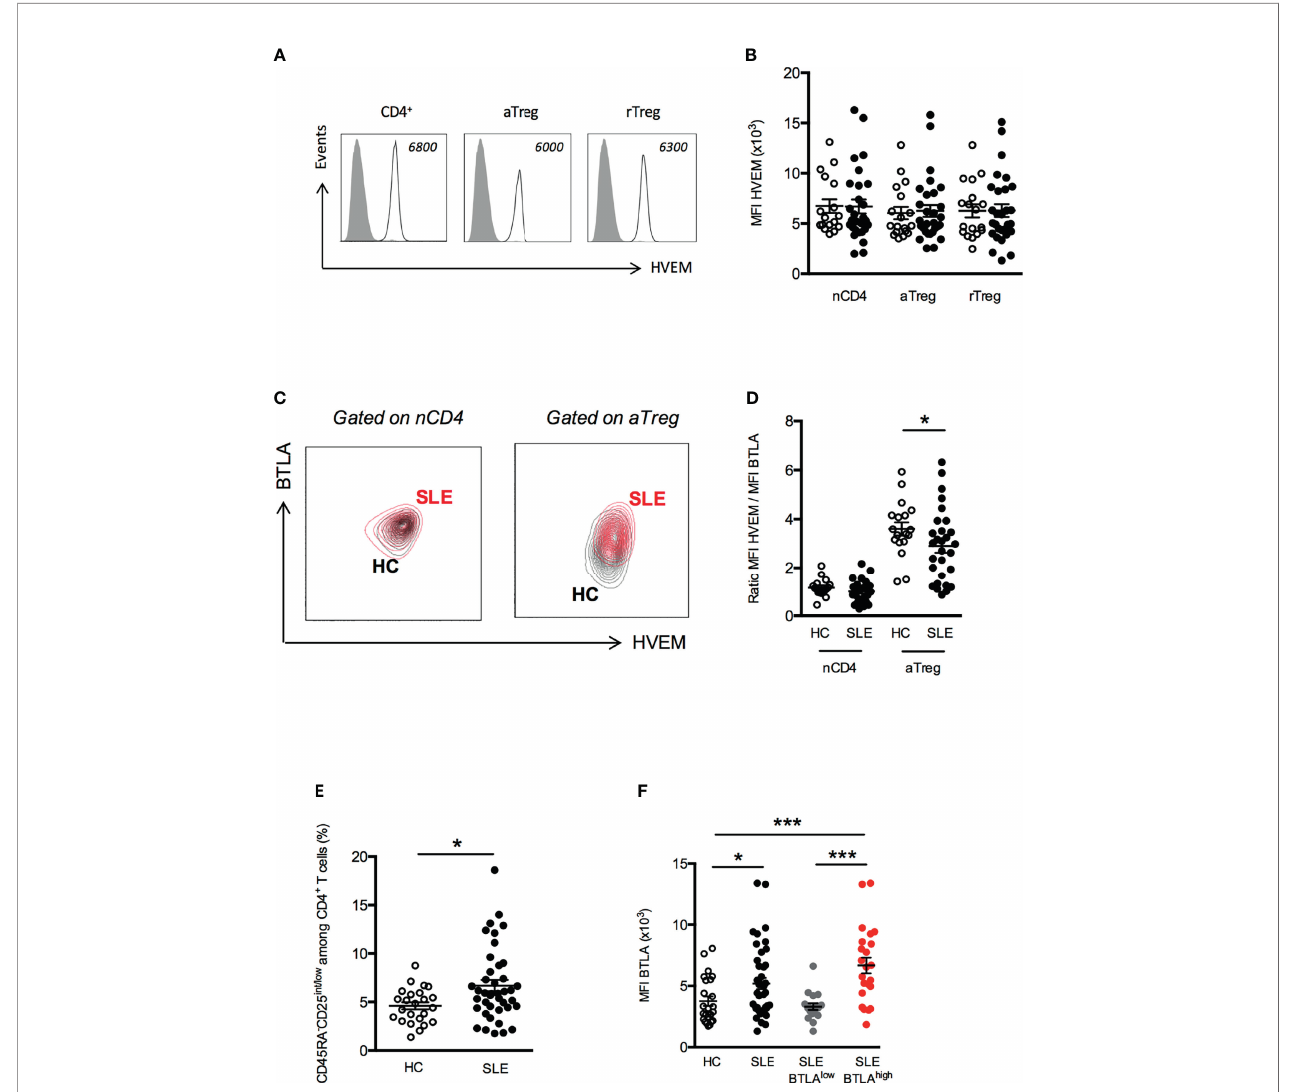
FIGURE 6 | Disturbed HVEM/BTLA ratio on aTregs from SLE patients. (A) Representative histograms of HVEM expression on T cell subsets. Data from a representative HC are shown as an example and MFI values are indicated. (B) Comparison of HVEM expression (MFI) on naive CD4 + T cells (nCD4), aTregs and rTreg in HC (white dots, n=18) and SLE patients (black dots, n=29). (C) Representative dot plot of BTLA and HVEM expression on naive CD4 + T cells and aTregs from a HC (in black) and a SLE patient (in red). (D) Comparison of the ratio of HVEM and BTLA expression on naive CD4 + T cells and aTregs in HC (white dots, n=18) and SLE patients (black dots, n=29). (E) Frequency of CD45RA - CD25 int/low CD4 + effector T cells among CD4 + T cells from HC (white dots, n=24) and SLE patients (black dots, n=41). (F) BTLA expression on CD45RA - CD25 int/low CD4 + effector T cells in HC (white dots, n=24), SLE patients (black dots, n=41), SLE patients with low BTLA expression by aTregs (grey dots, n=18) and SLE patients with high BTLA expression by aTregs (red dots, n=23). Results are expressed as mean ± SEM and each dot represents one individual. *p < 0.05; ***p < 0.001,